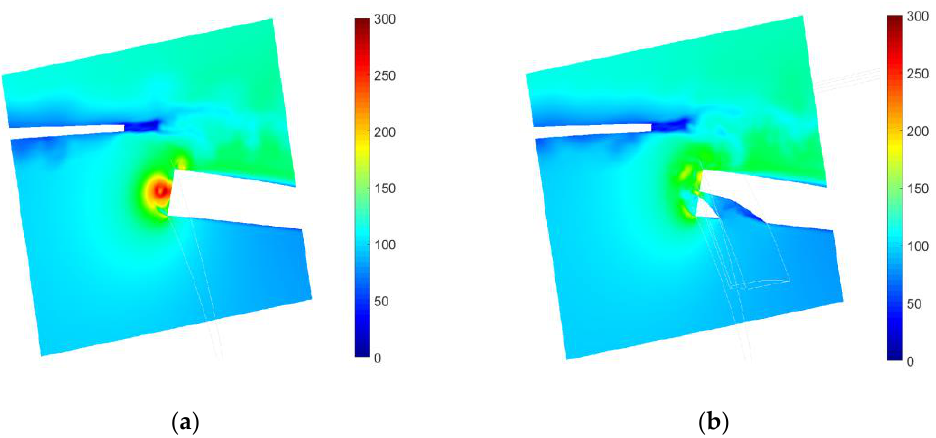
Figure 9. The comparison of the instantaneous velocity around the flap side-edge at a cross-section plane. ( a ) Baseline flap side-edge; ( b ) slotted flap side-edge.